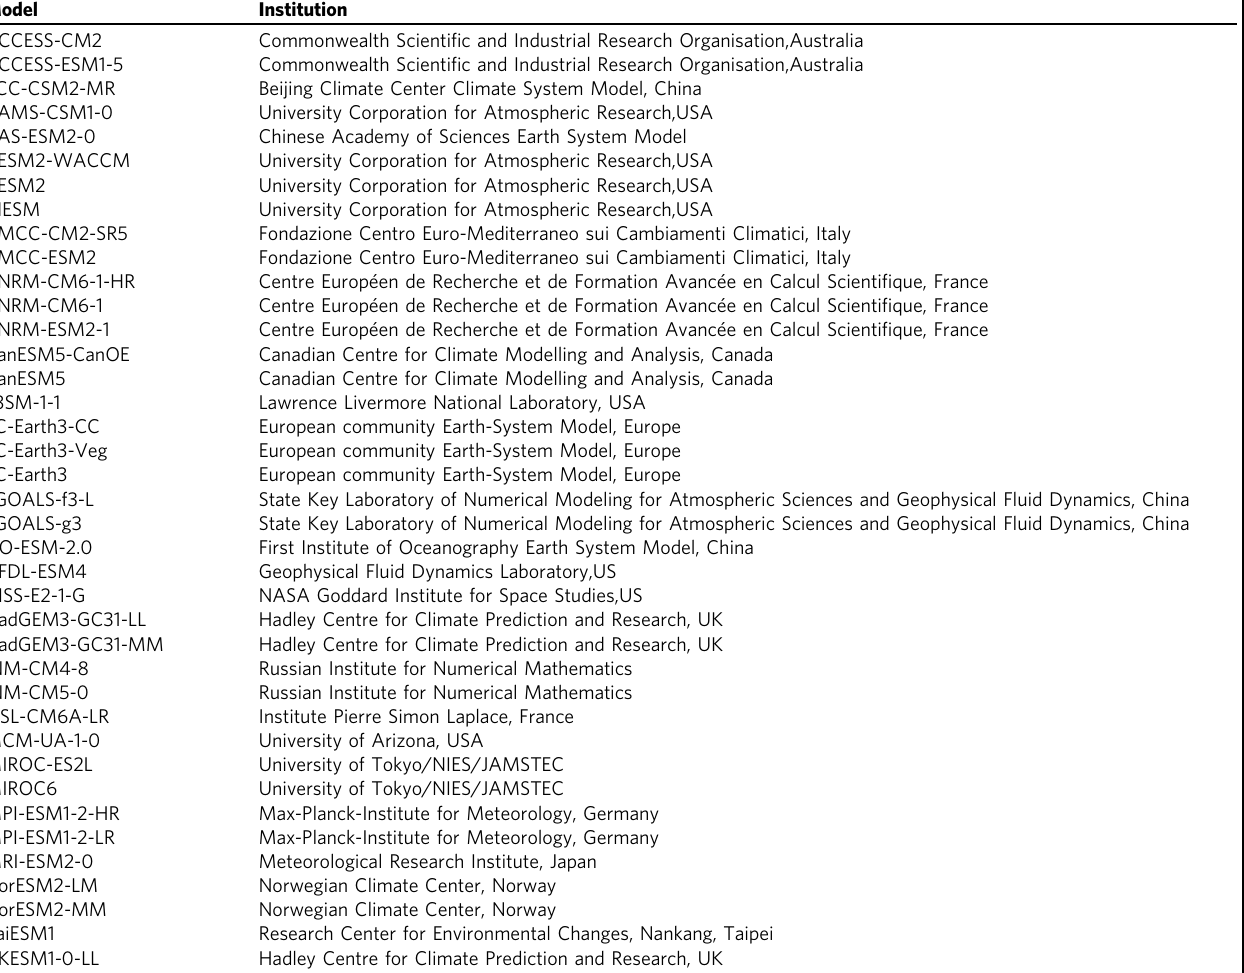
Table 2 List of primary (CMIP6) climate models used in this study.